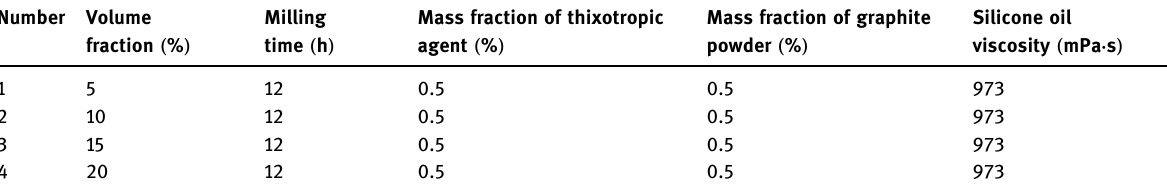
Table 1: Formula of MRF after adding thixotropic agent, surfactant and graphite powder Number Volume fraction ( % )